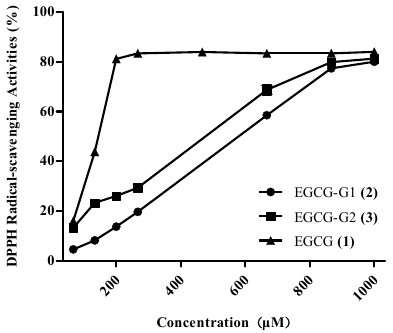
Figure 4. DPPH radical–scavenging activities of EGCG and EGCG glycosides: EGCG-G1 ( 2 ) (100 μ L of 4.04, 8.07, 16.13, 24.20, 241.95, 483.90, 873.60 μ M), EGCG-G2 ( 3 ) (100 μ L of 3.20, 6.39, 12.78, 19.17, 191.70, 383.40, 511.20 μ M) or EGCG (100 μ L of 5.46, 10.92, 21.84, 32.76, 327.60, 655.20, 870.4 μ M) was mixed with 0.13 μ M 1,1-diphenyl-2-picrylhydrazyl (100 μ L) in darkness at room temperature for 30 min, and the absorbance was monitored at 519 nm. Each value is the mean ± standard deviation ( n = 3).